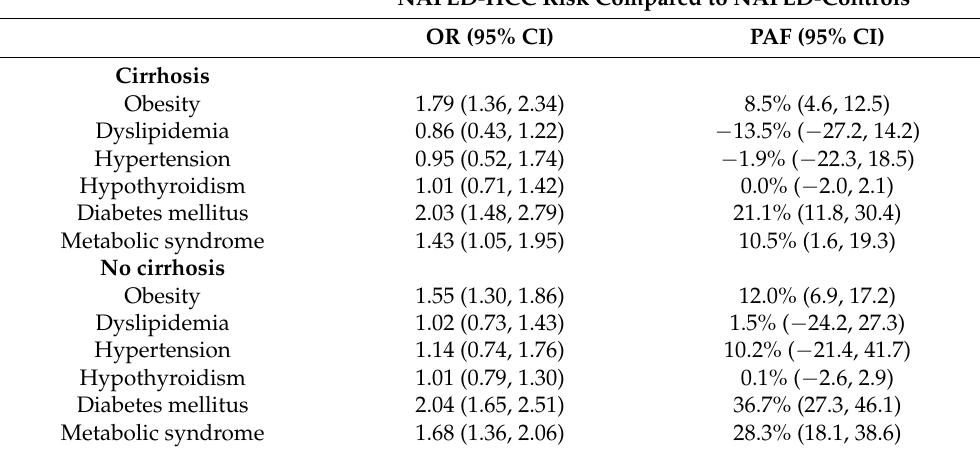
Table 4. Multivariable-adjusted odds ratios (ORs) and 95% confidence intervals (CIs) for associations between metabolic risk factors and NAFLD-HCC risk, and population-attributable risk fractions for each metabolic risk by cirrhosis status. NAFLD-HCC Risk Compared to NAFLD-Controls OR (95%